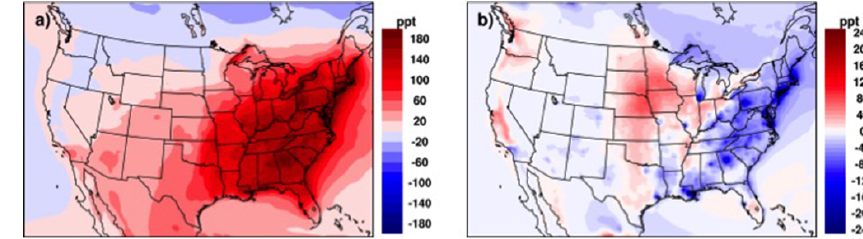
Figure 14. Differences in (a) RNO 3 and (b) NO x concentrations between Simulation 2 and Simulation 1.